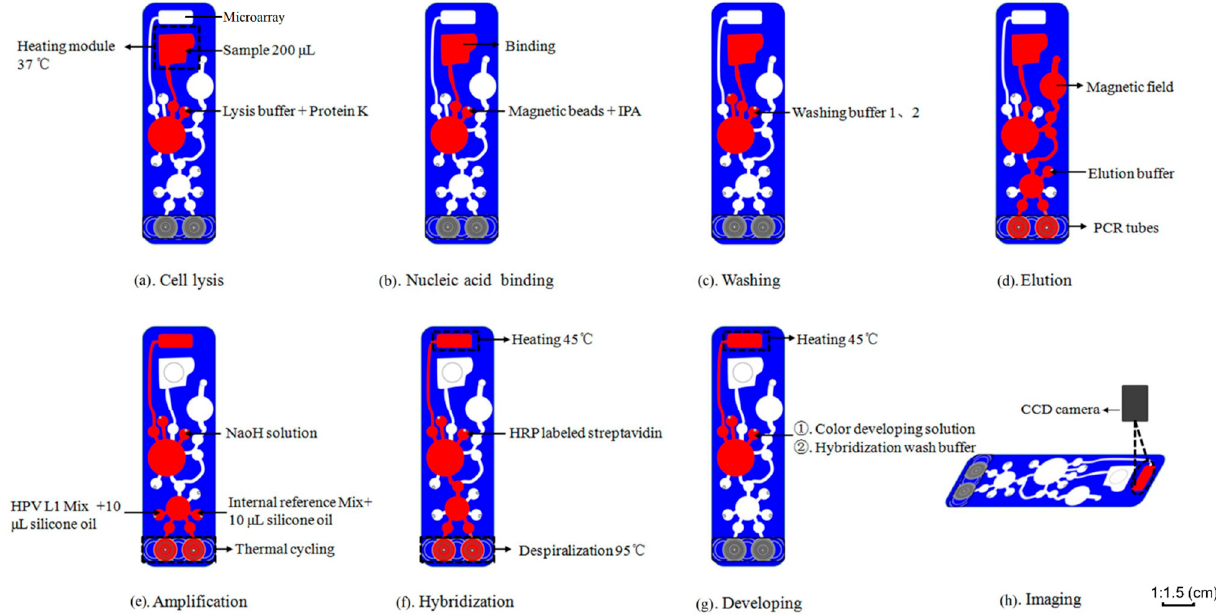
Figure 3. The CARD processing protocol. Illustration of flow control in CARD. Automatic sample detection process in CARD: ( a ) add lysis buffer and proteinase K to lyse cells, ( b ) magnetic beads binding DNA, ( c ) washing the DNA-bound magnetic beads with washing buffer, ( d ) add elution buffer to elute DNA, ( e ) add PCR amplification system for thermal cycling, meanwhile add membrane treating solution (NaOH) to activate the DNA microarray. ( f ) PCR amplification products are pyrolyzed into single strands and transfer to DNA microarray, then add HRP labeled streptavidin for incubation, ( g ) add color developing solution for color developing, then add Hybridization washing buffer to rinse the DNA microarray, ( h ) the CCD camera obtains image result.